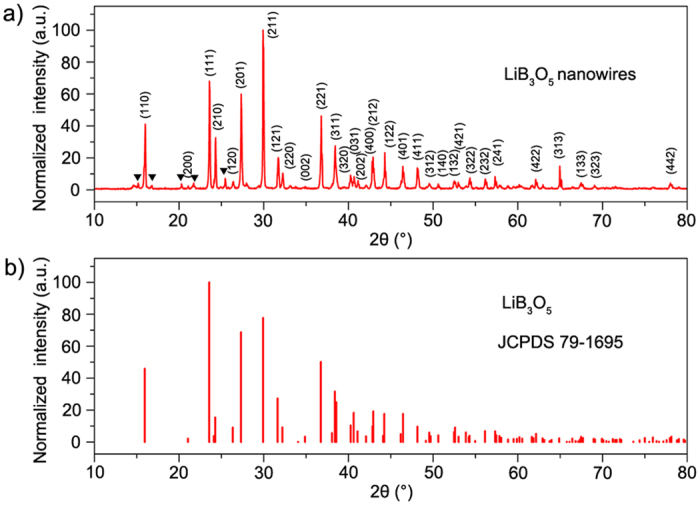
XRD pattern of (a) as-synthesized LBO nanowires and (b) LiB3O5 (JCPDS file no. 79-1695).